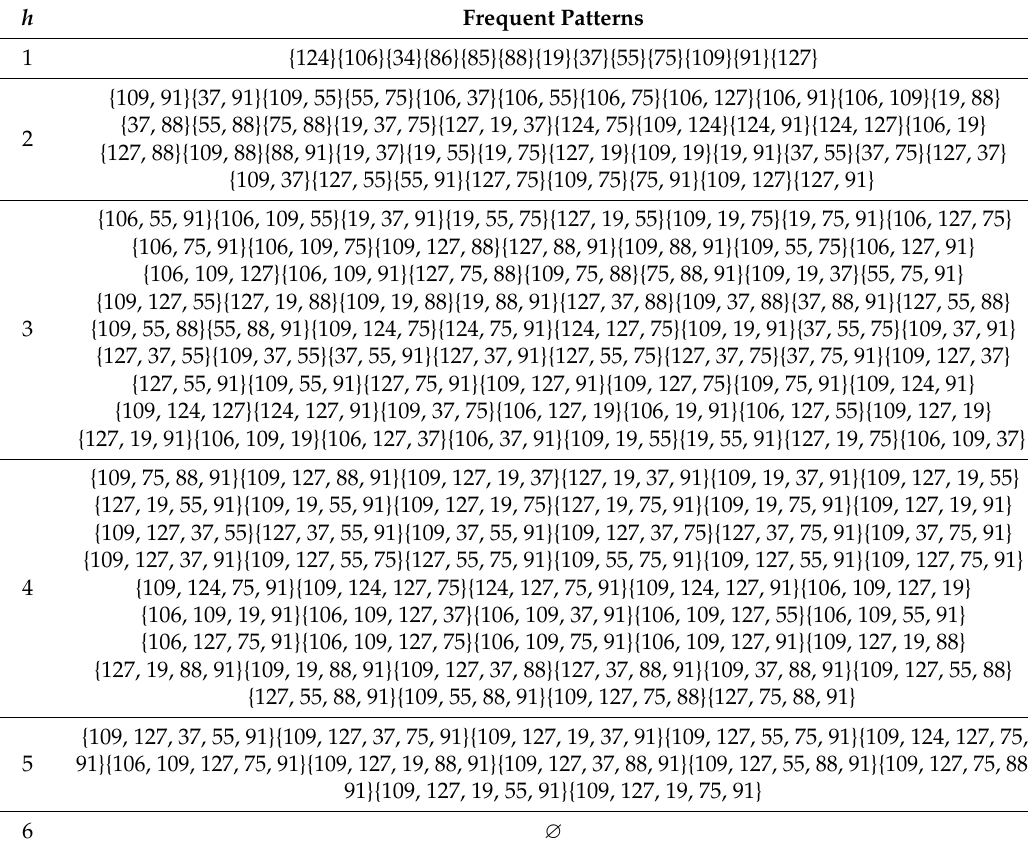
Table 8. Frequent patterns identified by ETPAM for the Connect